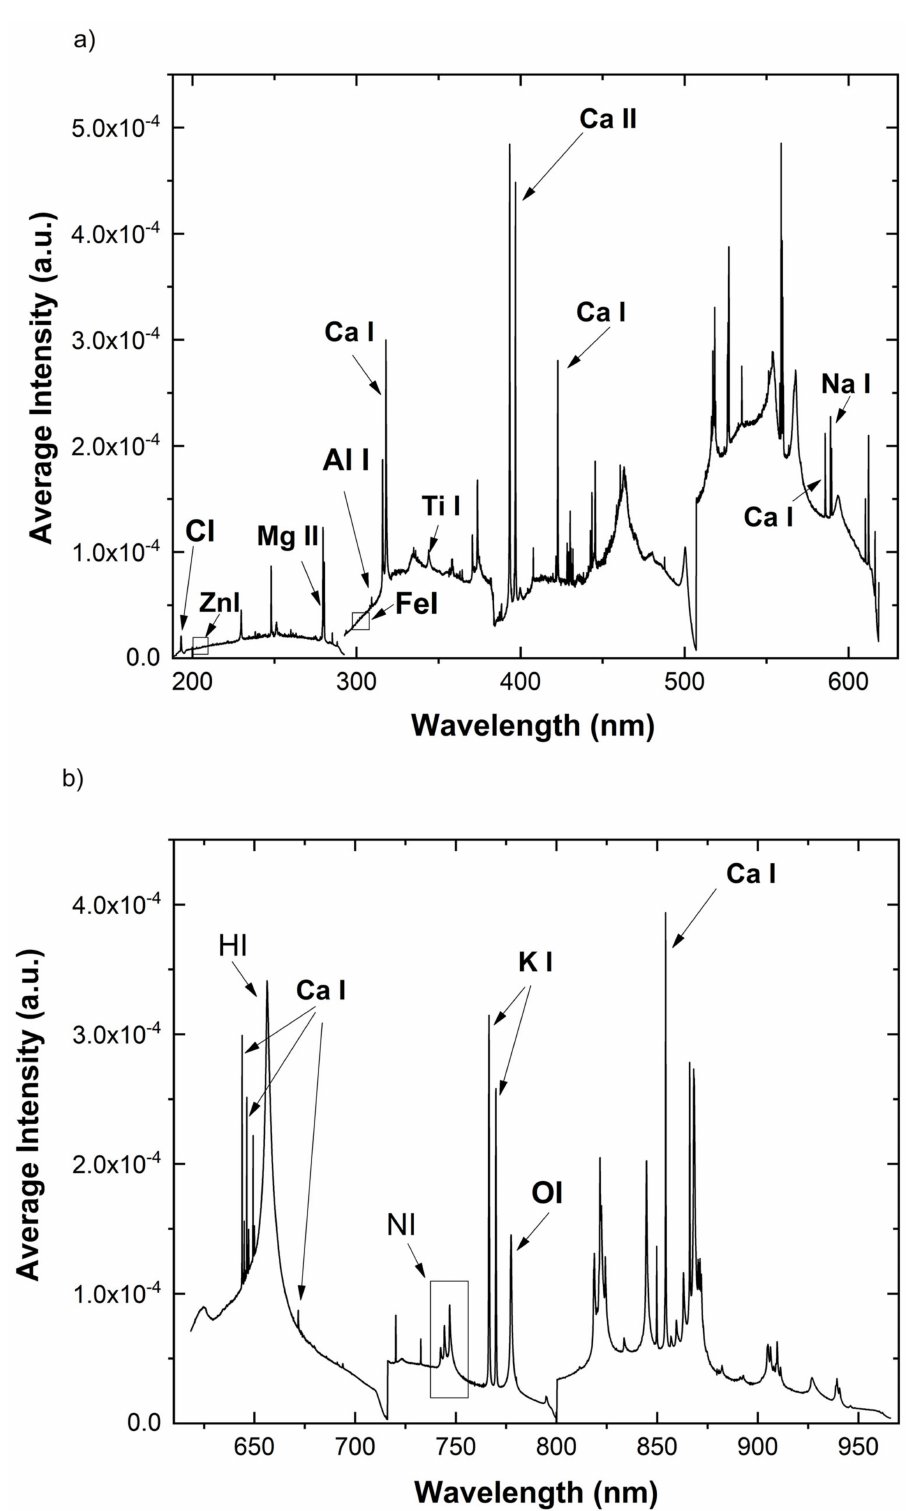
Figure 1. A typical LIBS spectrum of a sweet orange leaf in the spectral ranges 188.84 − 618.30 nm ( a ) and 618.30 nm − 966.22 nm ( b